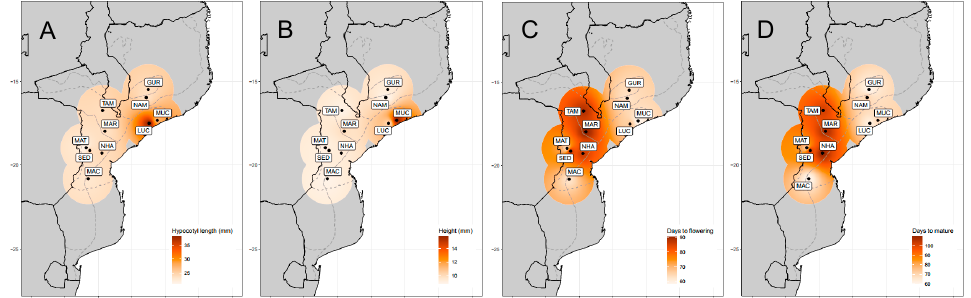
Figure 3. Spatial distribution of hypocotyl length ( A ), plant height ( B ), days to flowering ( C ) and days to mature ( D ). Names of landraces follow Table 1.